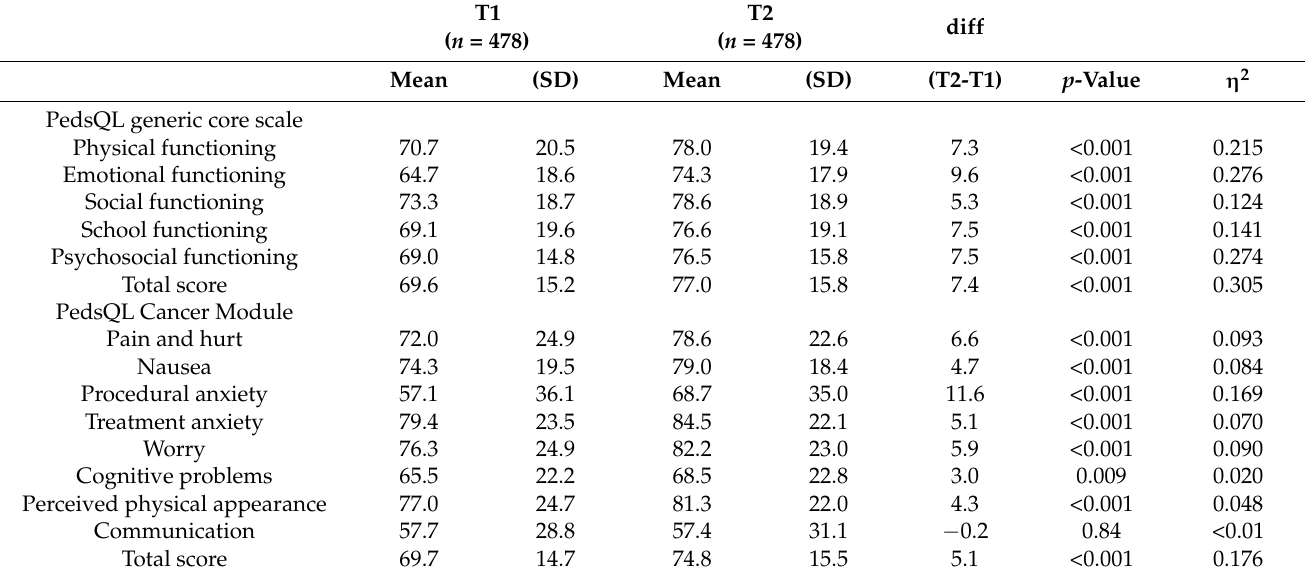
Table 4. Self-reported quality of life of the pediatric patients before and after rehabilitation (parent